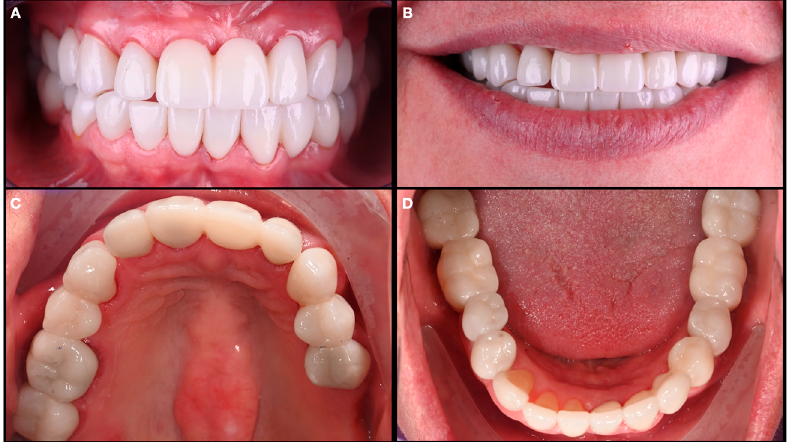
Figure 12. Final restorations. ( A ) Frontal view of maximum intercuspation position. ( B ) Smile. ( C ) Maxillary occlusal view. ( D ) Mandibular occlusal view.